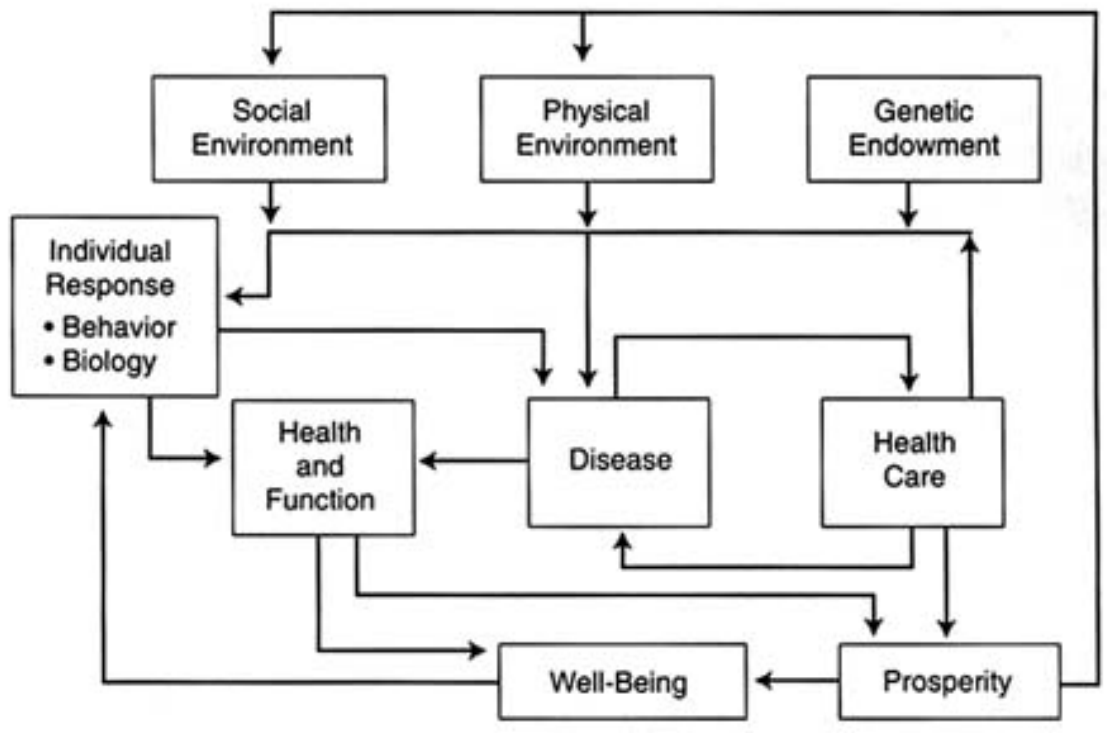
Figure 1. The determinants of health ( reprinted from [18] with permission from Elsevier ®